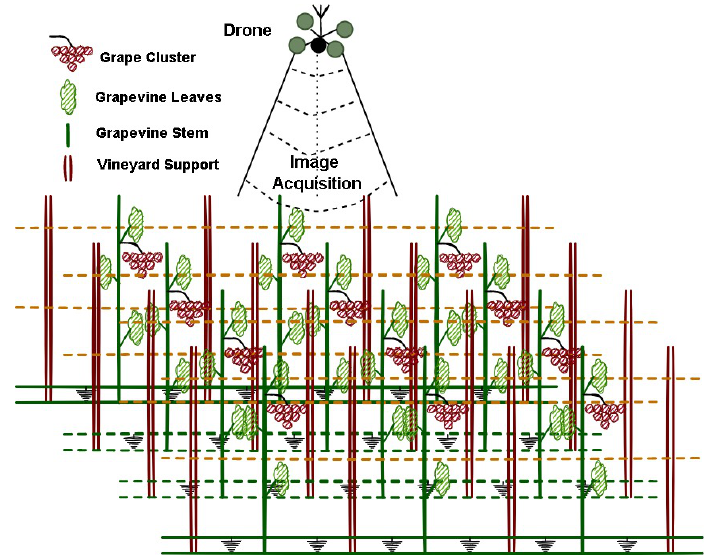
Figure 6. A schematic of inspection from the